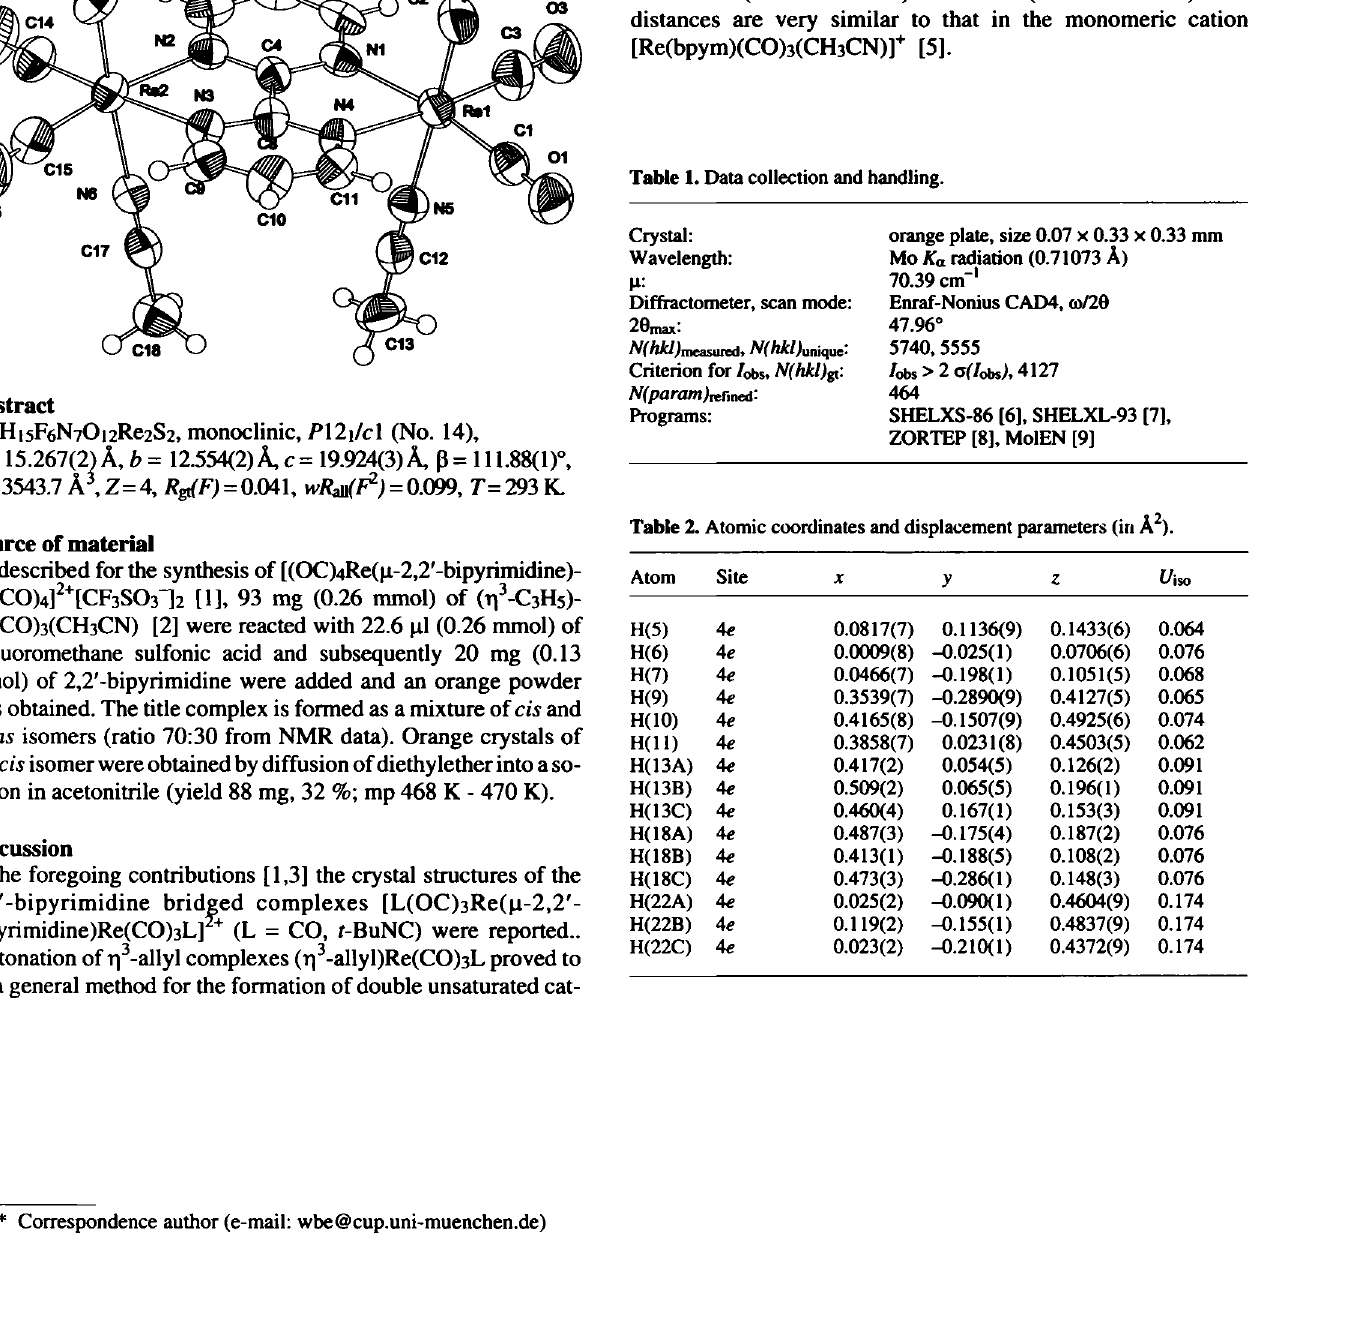
Table 1. Data collection and handling.